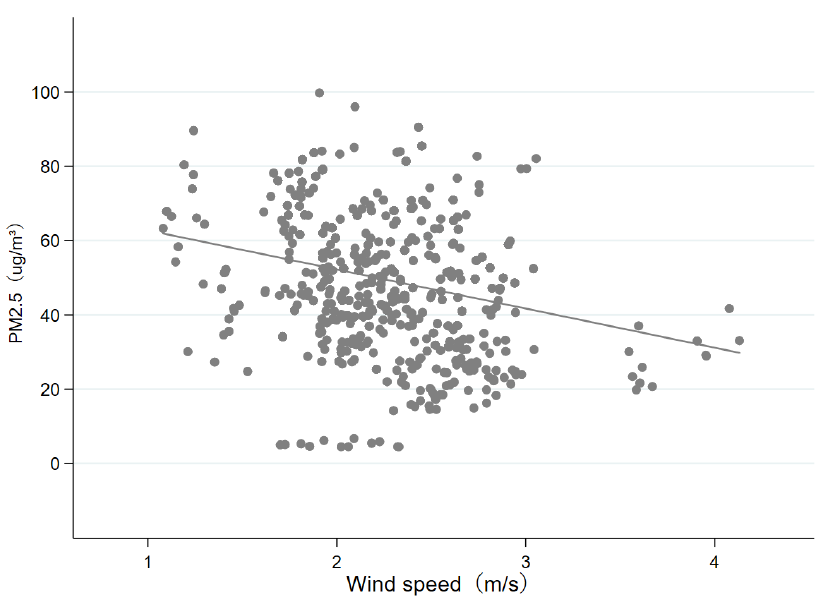
Figure 3. Wind speed and PM 2.5 concentration. Note: This figure displays the relationship between annually average wind speed and the PM 2.5 concentration of all sample cities.